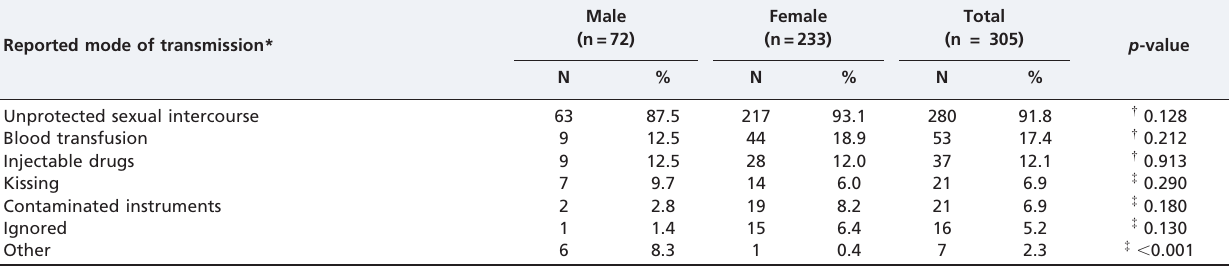
Table 3 - Knowledge about modes of HIV transmission in elderly individuals attending senior community centers in Campo Grande, MS, Brazil, 2009.